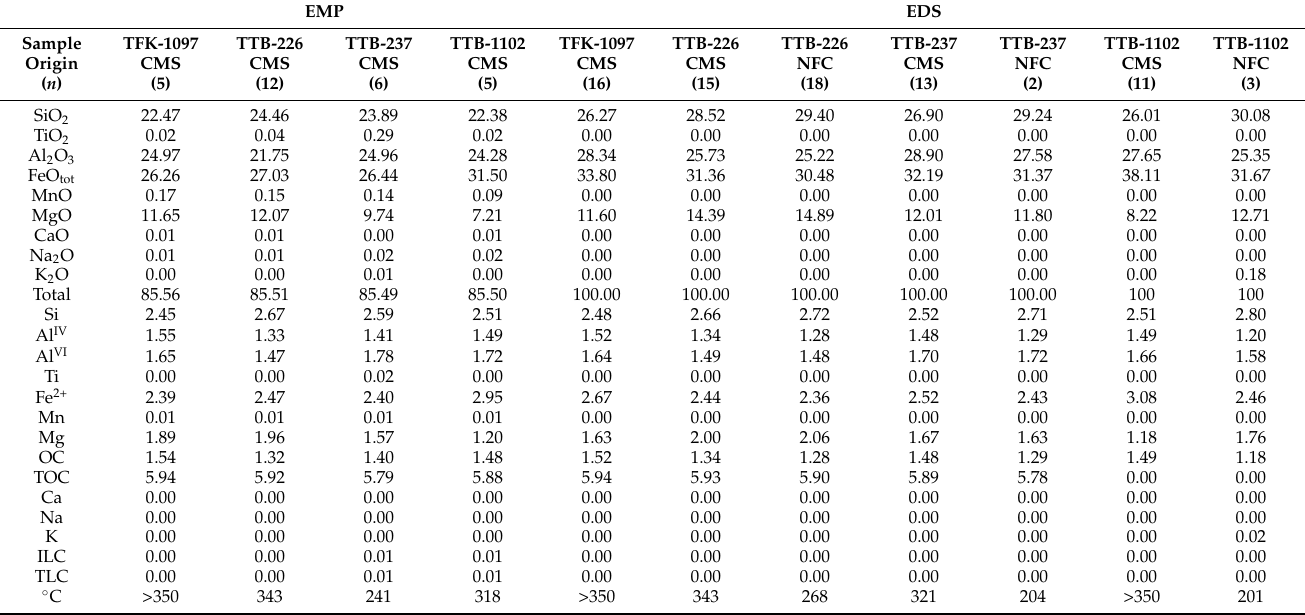
The mineral chemistry data of chlorites in the early Paleozoic metaclastic rocks (Table 3) show moderately narrow distributions of Si–R 2+ and Al IV –Fe/(Fe + Mg) dia- grams (Figure 10). However, the compositions of chlorites in CMS and neoformed ones range among clinochlore/daphnite, amesite and sudoite end-members, almost places be- tween clinochlore/daphnite and amesite (Figure 10a,b). Both neoformed and detrital (CMS) chlorites of the sample in early Ordovician (Tremadocian) parts exhibit reasonably different compositions than others because of the higher Si and R 2+ contents. Neoformed chlorites have higher Si contents than those of detrital (CMS) chlorites. Although the chlorites are shown to have brunsvigite-ripidolite composition in the Al IV –Fe/(Fe + Mg) diagram (Figure 10c,d), in accordance with AIPEA nomenclature [52], the Fe/(Fe + Mg) content of chlorites indicate the chamosite composition (Fe/(Fe + Mg > 0.5). The detrital chlorites have higher Al IV and Fe contents than their neoformed